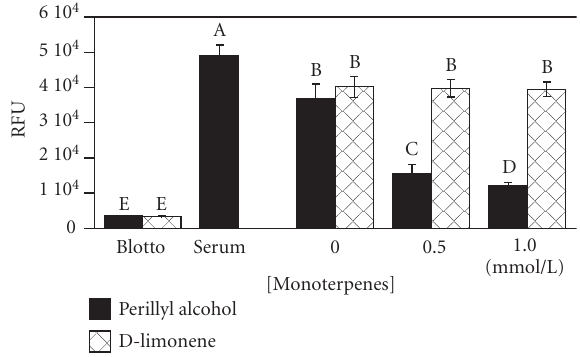
Figure 2. Perillyl alcohol, but not d-limonene, inhibits breast cell migra- tion. MCF-10A cells were allowed to migrate towards the bottom side of an 8- µ m pore filter coated with fibronectin for 18 hours in serum-free mini- mal medium containing the indicated concentrations of monoterpenes, or serum as a control. Migration towards nonfat dried milk (blotto) served as a negative control for random migration. Migration was quantitated by flu- orescently labeling cells on the bottom of the filters and reading the fluores- cence with a plate reader. Results expressed as mean of Relative Fluorescence Units, ± standard deviation ( n = 3). A student-Numan-Keuls test identified five groups (letters A–E; P ≤ . 05) which were statistically di ff erent from one another (ANOVA F:[7, 23] = 231.76, P < . 0001).